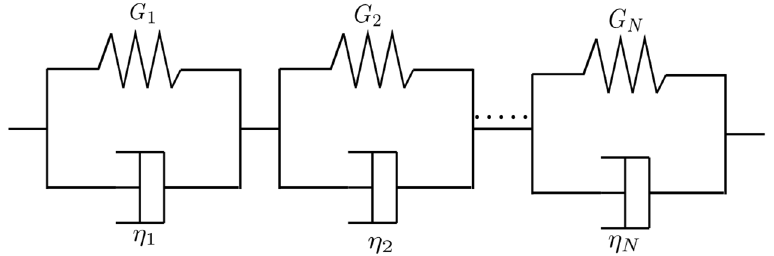
Figure 3. The generalized Kelvin